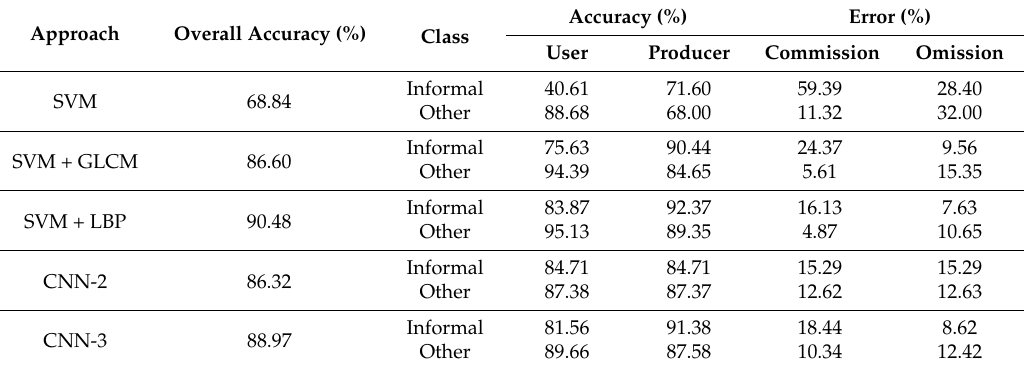
Table 5. Accuracy assessment for the methods SVM, SVM + GLCM and CNN computed by combining the confusion matrix of Tile 1, Tile 2 and Tile 3.